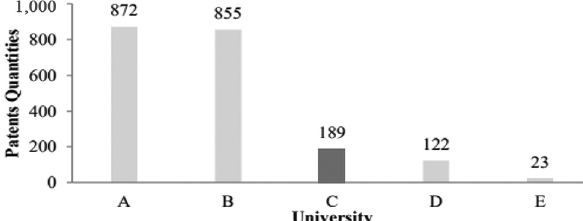
Figure 1. Total of patents fi